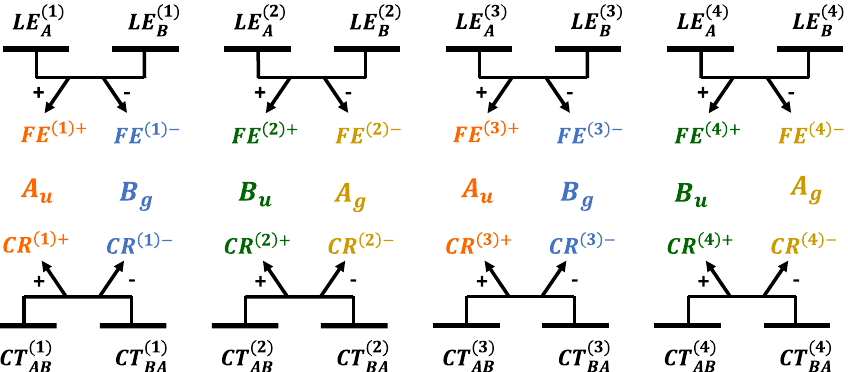
Figure 3. Definition of SA diabatic states ( FE , CR , each symmetry with a specific color code used throughout this work: yellow for A g , orange for A u , blue for B g and green for B u ) defined as linear combinations of diabatic states (black, LE , CT ) and employed to analyze the nature and the effect of interactions on the adiabatic exciton states of oligoacene dimers.